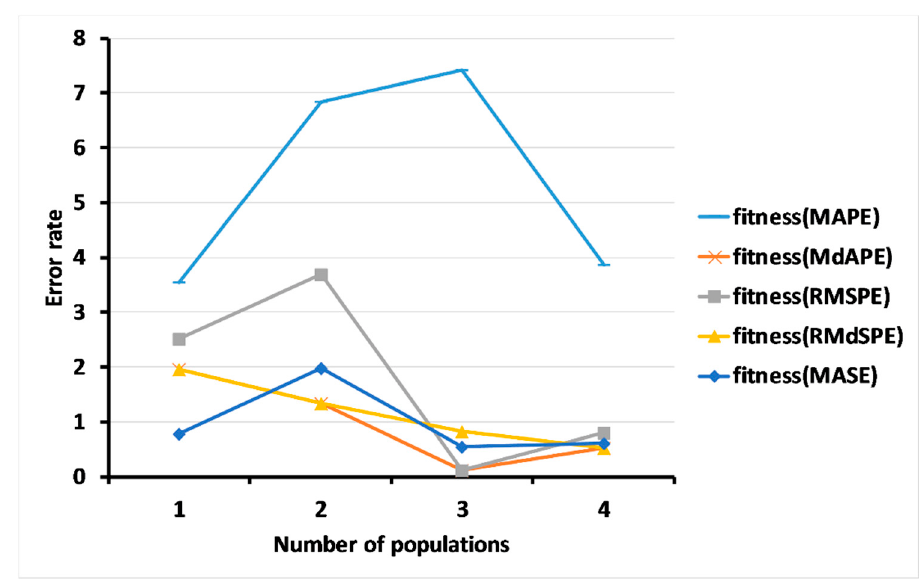
Figure 7. Material cost error rate.